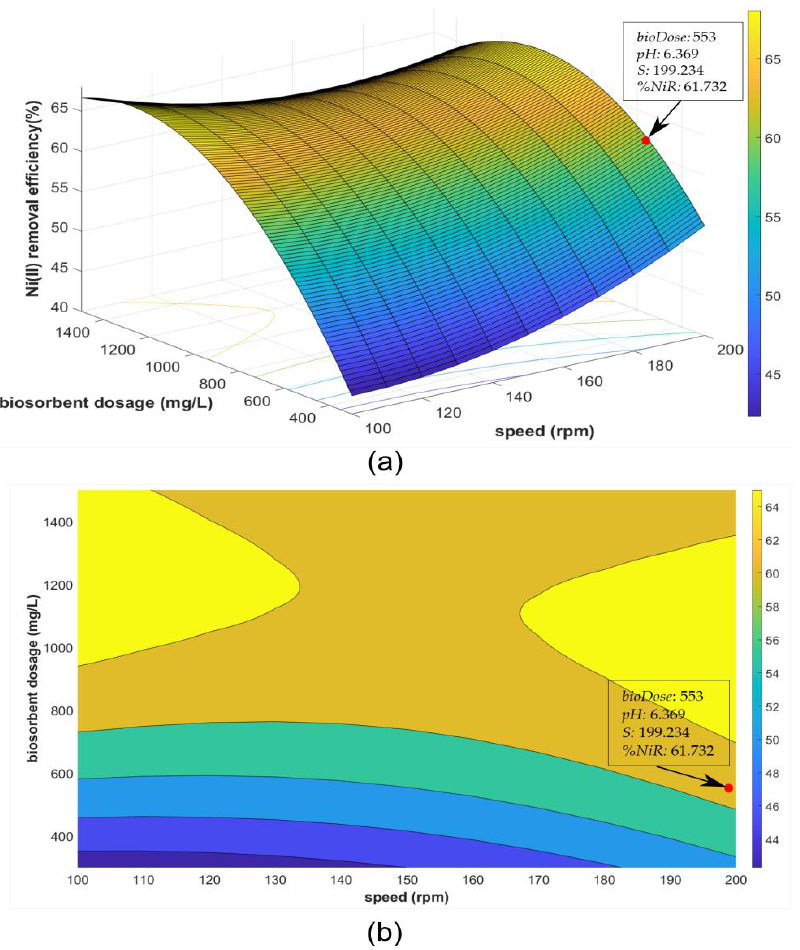
Figure 6. First optimization scenario: ( a ) response surface plot showing the e ff ect of S and bioDose , ( b ) contour plot showing the optimal point